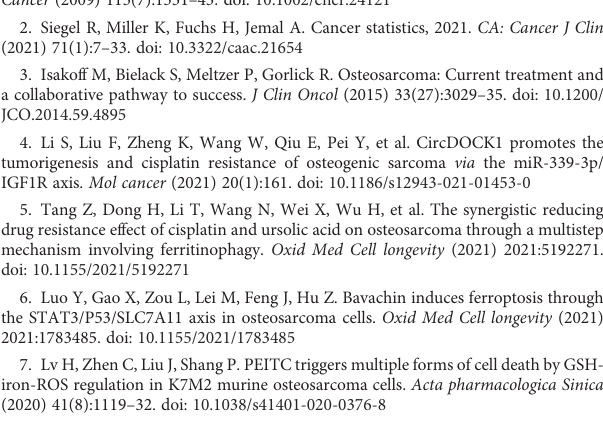
FIGURE S1 Work fl ow diagram of this study. FIGURE S2 Figure S2 (A) The expression of immune cells in two Cu Clusters. (B) The expression of immune cells in two CRP score groups. (C) The expression of checkpoints in two CRP score groups. (D) The correlation of drug response and CRP score. FIGURE S3 Figure S3 Pharmacogenomics Analysis of CRP score. (A) Signaling pathways targeted by drugs resistant or sensitive to CRP_score in OS cell lines; (B) Molecular targets and signaling pathways targeted by drugs resistant or susceptible to CRP_score in OS samples predicted by the Oncopredict